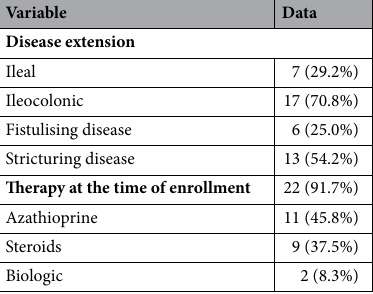
Table 1. Clinical characteristics of enrolled patients with Crohn’s